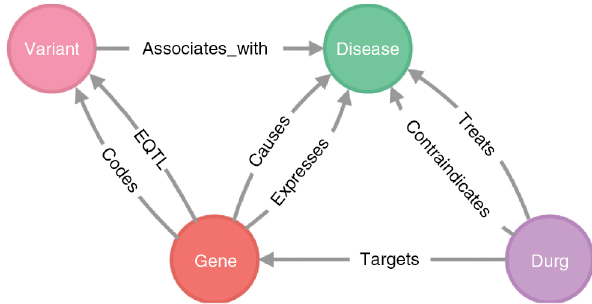
Figure 2: Data model of the GenCoNet database.